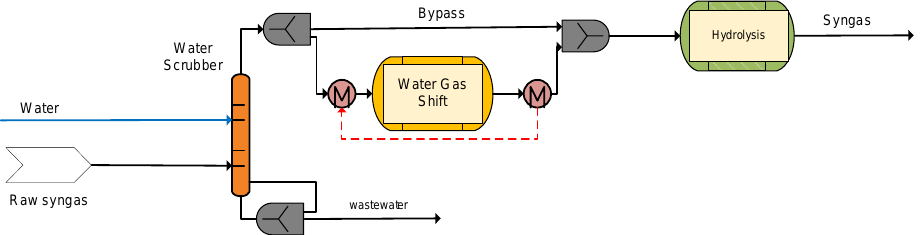
Figure 4. Syngas scrubbing–raw gas shift–COS hydrolysis flow diagram .